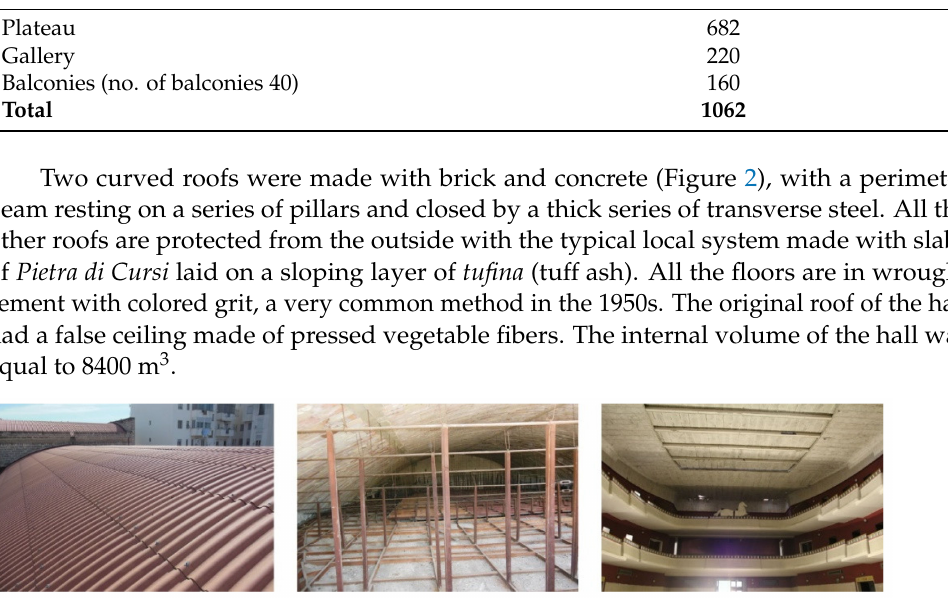
Figure 2. Combo 00—Original curved roof with false ceiling of pressed vegetable fibers.